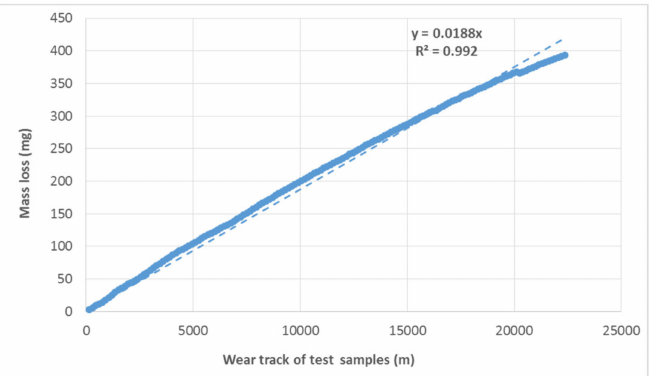
Figure 9. Course of wear of the tested material (mass loss is cumulative depending on the track) under a load of 1600 g.